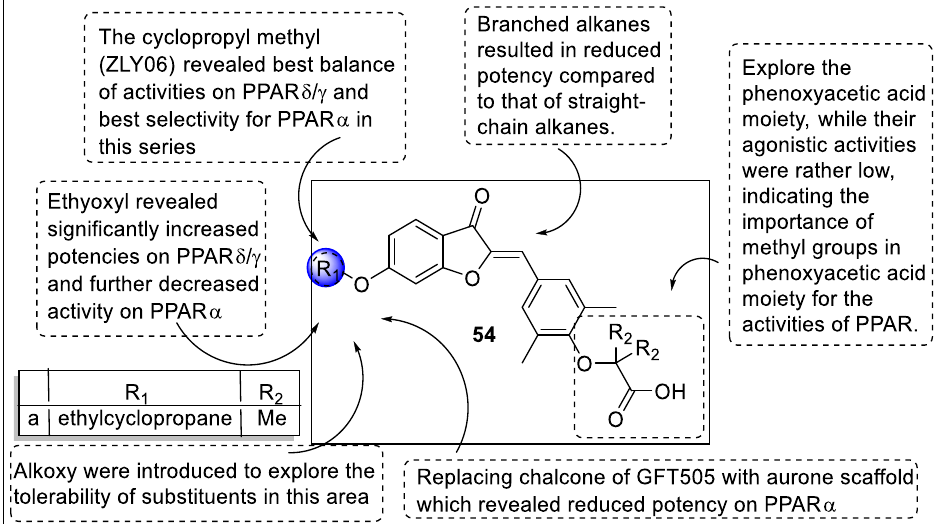
Figure 58. Structural activity relationship of GFT505 hybrids as potent PPAR ligands.